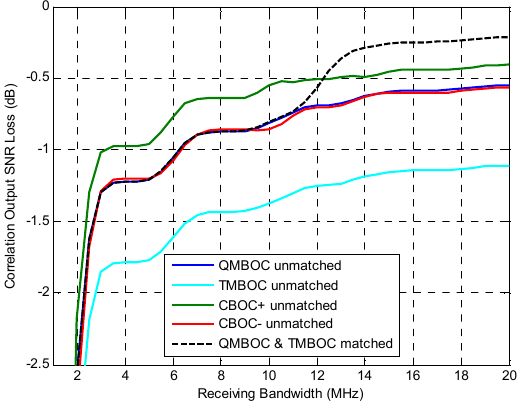
Figure 6. The correlation output SNIR loss of multiple implementation of MBOC(6,1,1/11) signals, under matched receiving and BOC 11 -like unmatched receiving. It can be used to characterize the acquisition performance of MBOCs.